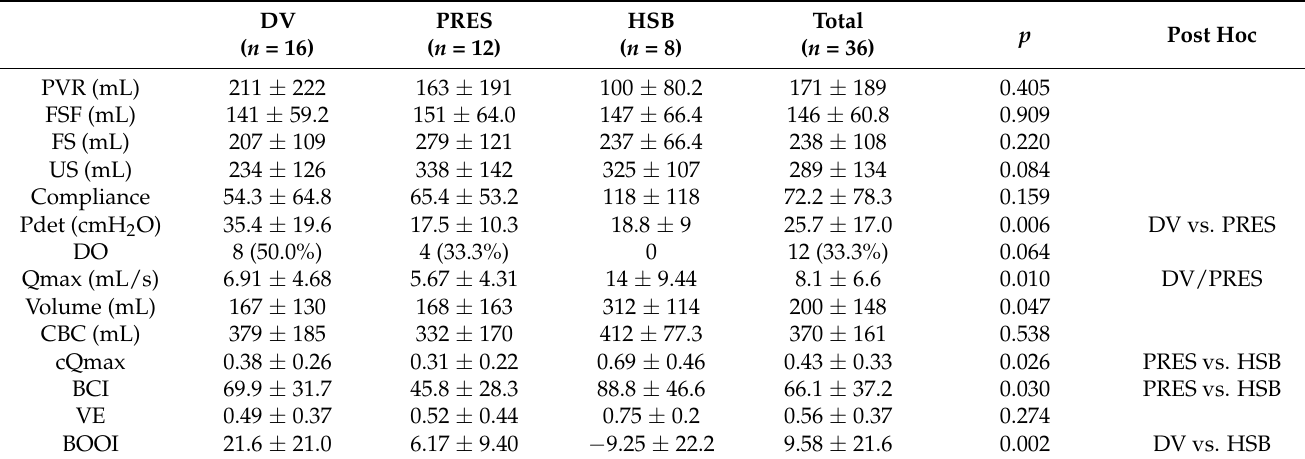
Table 3. The baseline videourodynamic parameters among the three groups of patients with voiding